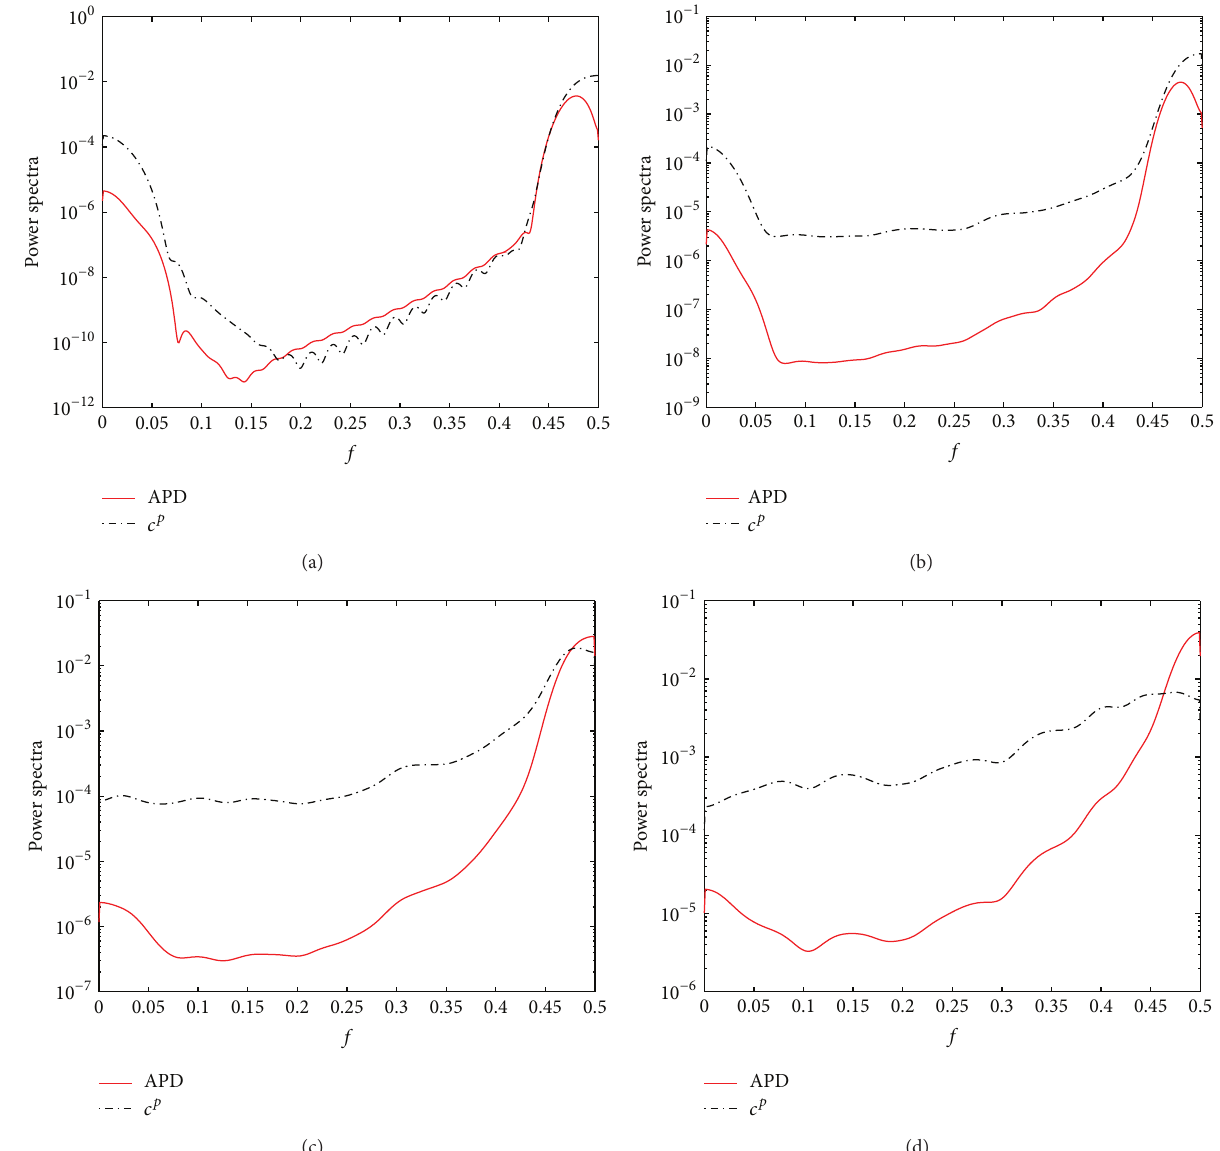
Figure 6: Power spectra of the coupled system (10), for the two corresponding time series obtained in Figure 3(a). (a) 𝜖 = 0 , (b) 𝜖 = 0.005 , (c) 𝜖 = 0.05 , and (d) 𝜖 = 0.5 . To facilitate comparisons, the spectra are normalized to unit